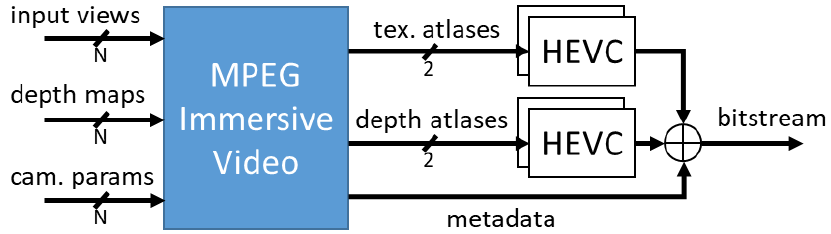
Figure 2. Four atlases for the Painter sequence [5]: two full-resolution texture atlases (left: first texture atlas containing a subset of stacked input views, middle: second texture atlas containing “patches” from other input views), and two reduced-resolution depth atlases (right: two depth atlases, containing depth values which correspond to the objects in both texture